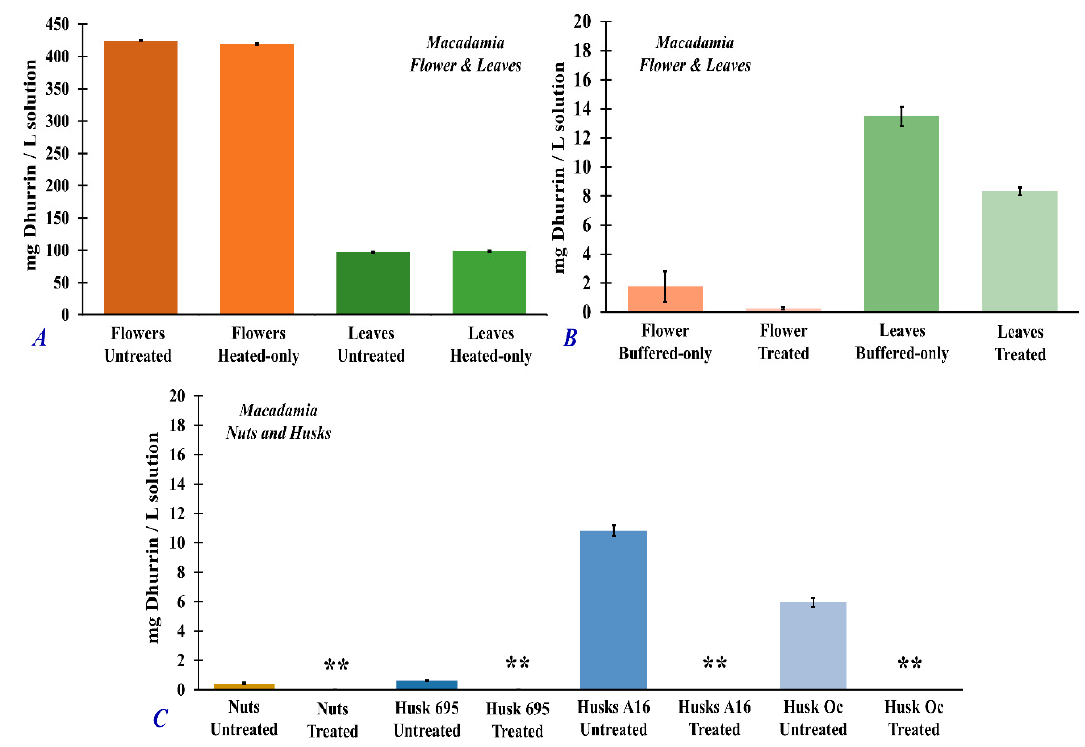
Figure 6. Dhurrin concentration (mg dhurrin/L solution) measured by HPLC-DAD from the different extracts of Macadamia plant parts (( A and B ) flowers and leaves ; ( C ) nuts and husks varieties 695, A16, and Oc) in untreated samples (fresh, no treatment), heated-only samples (50 °C for 60 min), buffered-only samples (samples treated with pH 7, Na 2 HPO 4 –citric acid buffer solution), and treated samples (samples treated with pH 7, Na 2 HPO 4 –citric acid buffer solution and heated at 50 °C for 60 min). ** Means negligible values. Standard error analysis was evaluated at 95% confidence intervals.